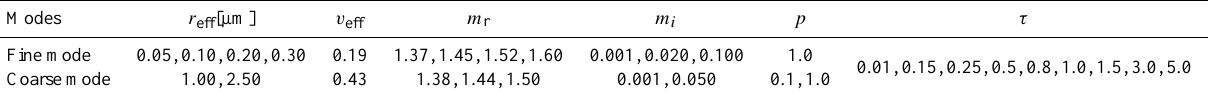
to backward scattering. To get measurement configurations with different angular resolution, viewing angles are evenly sampled from − 60 . 0 to 60 . 0 ◦ according to the resolution ex- cept in the measurement configurations with two viewing an- gles for which we use nadir and − 60 . 0 ◦ . Aerosol size distri- bution parameters used here are randomly distributed in their ≤ 0 . 30 µm, acceptable range for both fine mode (0 . 1 ≤ r s eff ≤ 0 . 30) and coarse mode (0 . 60 ≤ r c ≤ 3 . 50 µm, 0 . 1 ≤ v s eff eff ≤ 0 . 6). To account for the spectral dependence, the 0 . 4 ≤ v c eff refractive indices for each mode are linear combinations of the refractive index spectra as shown in Fig. 2. The AOD τ for each mode varies randomly in the range 0 . 0 < τ 550 ≤ 0 . 70. Aerosol layer center height are fixed to be 2000 m with a width of 2000 m. We consider soil and vegetation land sur- faces of RPV model and the modified Fresnel model with parameters presented in Table 4 (Litvinov et al., 2011). Pa- rameters ρ 0 at 410, 470, 550 and 865nm are obtained by lin- ear interpolation using soil and vegetation surface reflectance provided by ASTER spectral library (Baldridge et al., 2009). The forward model as described in Sect. 3 was used to simulate the intensity vector at the altitude of RSP (20km) for all 1000 combinations of input parameters. In our simu- lations, we add an random noise of 2.0 % on intensity I and 0.2 % on DOLP P to account for measurement